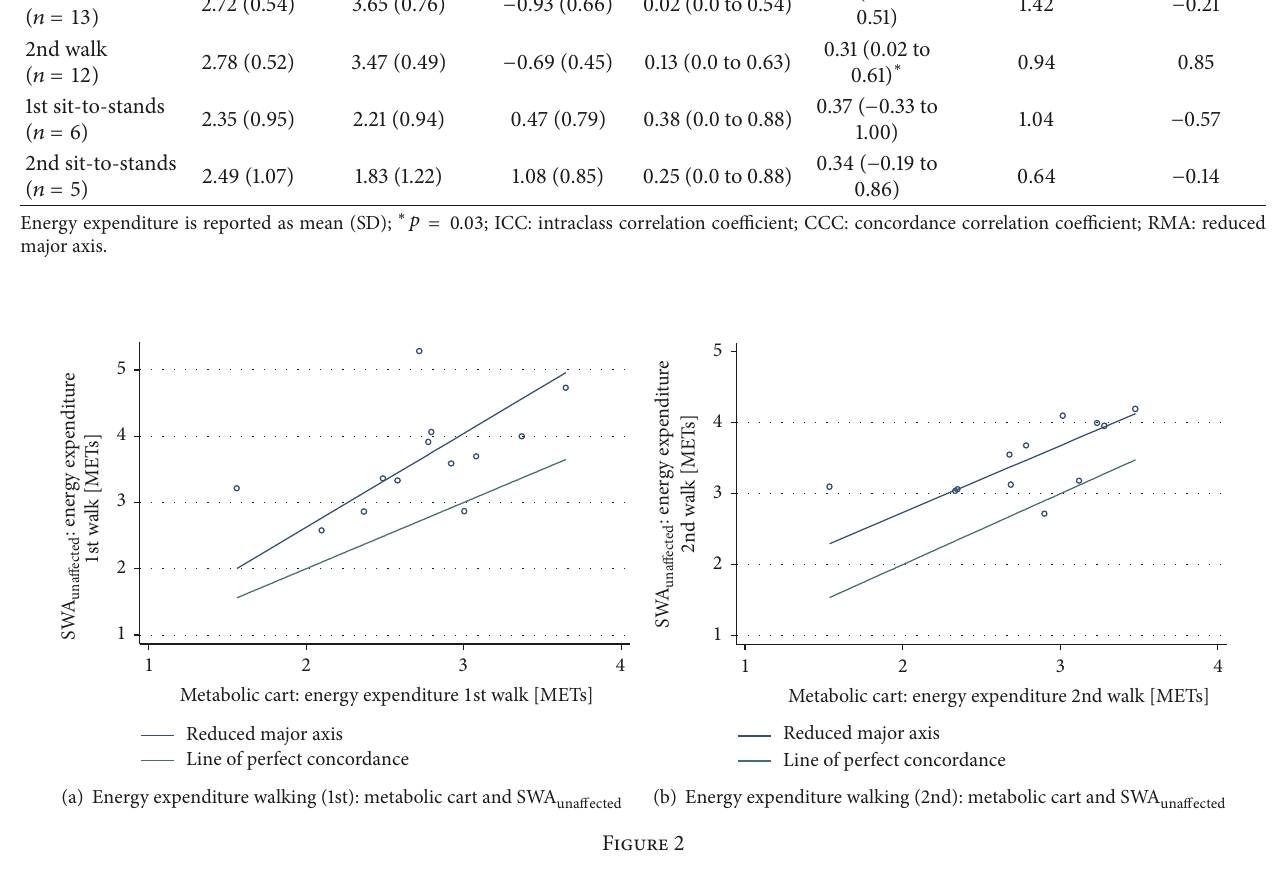
Table 2: Energy expenditure of walking and sit-to-stands and agreement between the metabolic cart and SWA unaffected . Outcome energy expenditure (METs) Activity bout ( 𝑛 ) Metabolic